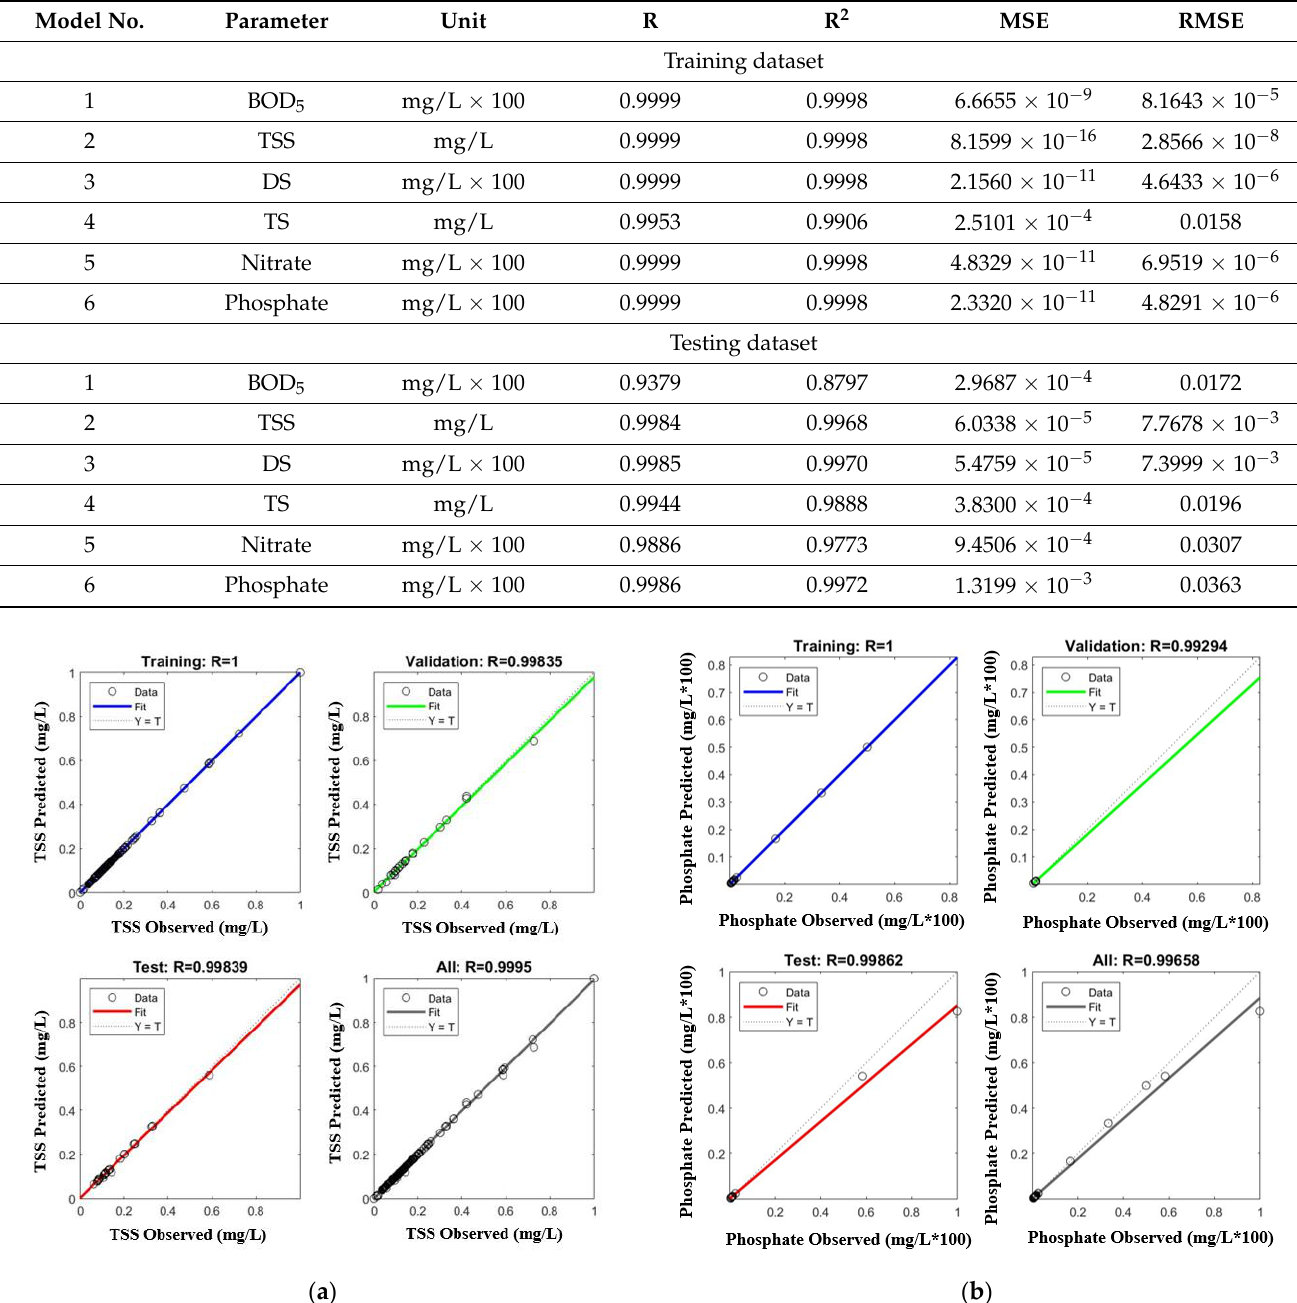
Figure 5. Regression plots of ( a ) model 2 and ( b ) model 6.